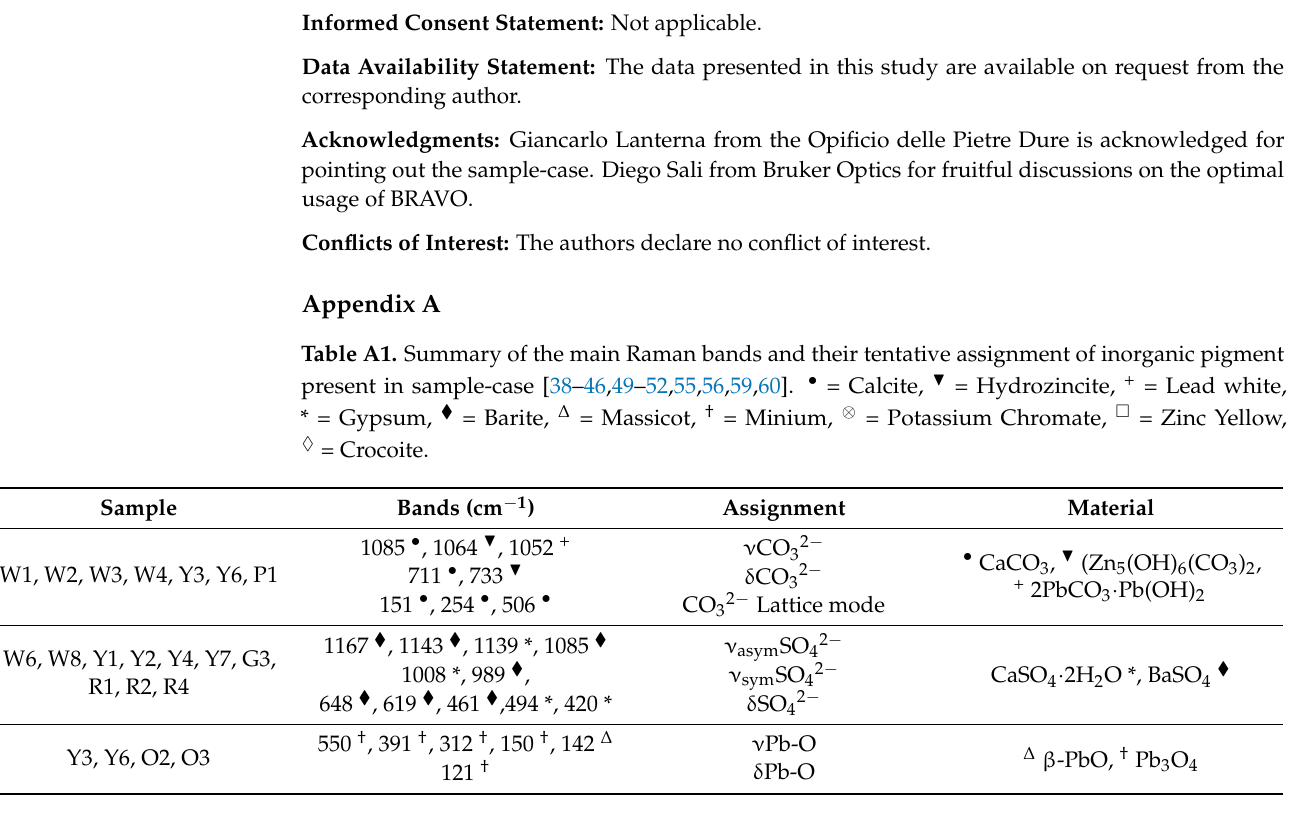
(cid:72) = Hydrozincite, + = Lead